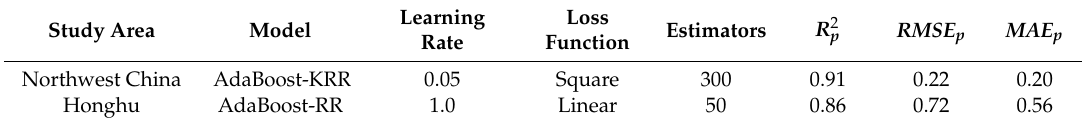
Table 4. The results of the quantitative inversion models of soil organic